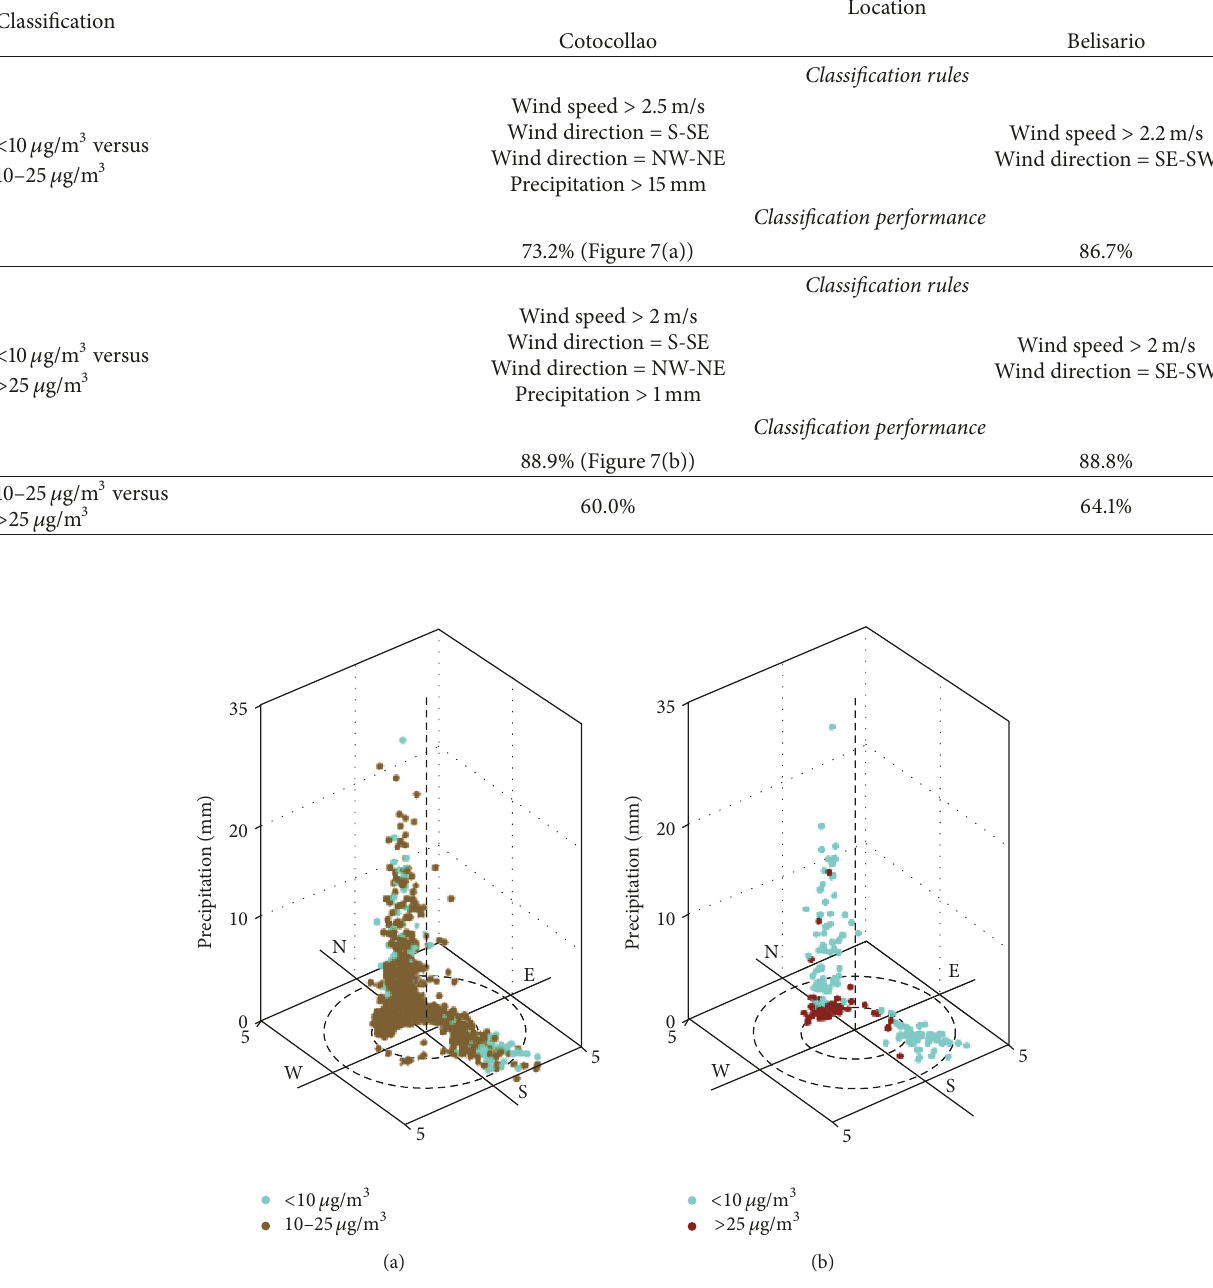
Figure 7: Data split for three different classes (see Table 6): (a) < 10 𝜇 g/m 3 versus 10–25 𝜇 g/m 3 and (b) < 10 𝜇 g/m 3 versus > 25 𝜇 g/m 3 . Both (a) and (b) are results for Cotocollao mapped in terms of wind direction, wind speed, and precipitation. The inner circle represents wind speeds up to 2 m/s and the outer circle represents wind speeds up to 4